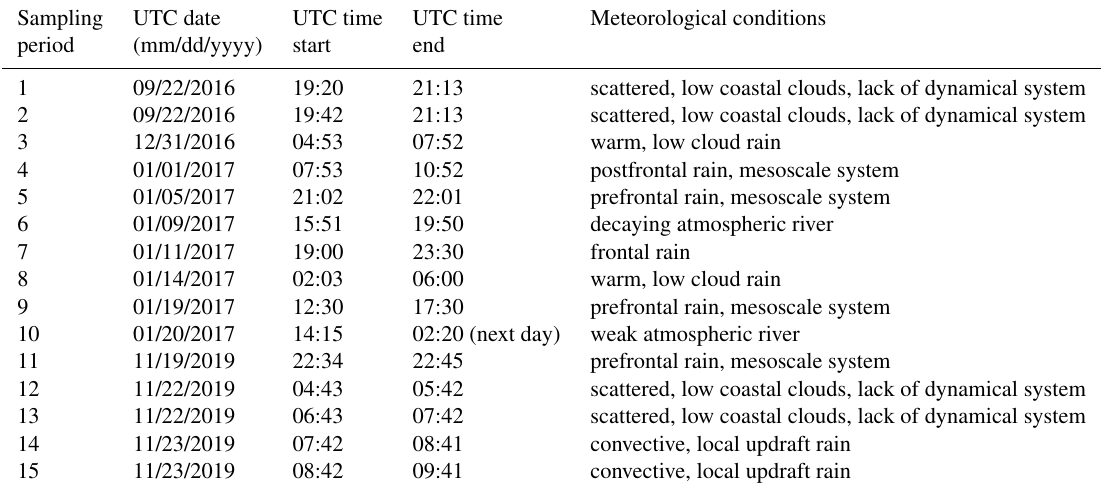
Table 1. Precipitation sampling periods.